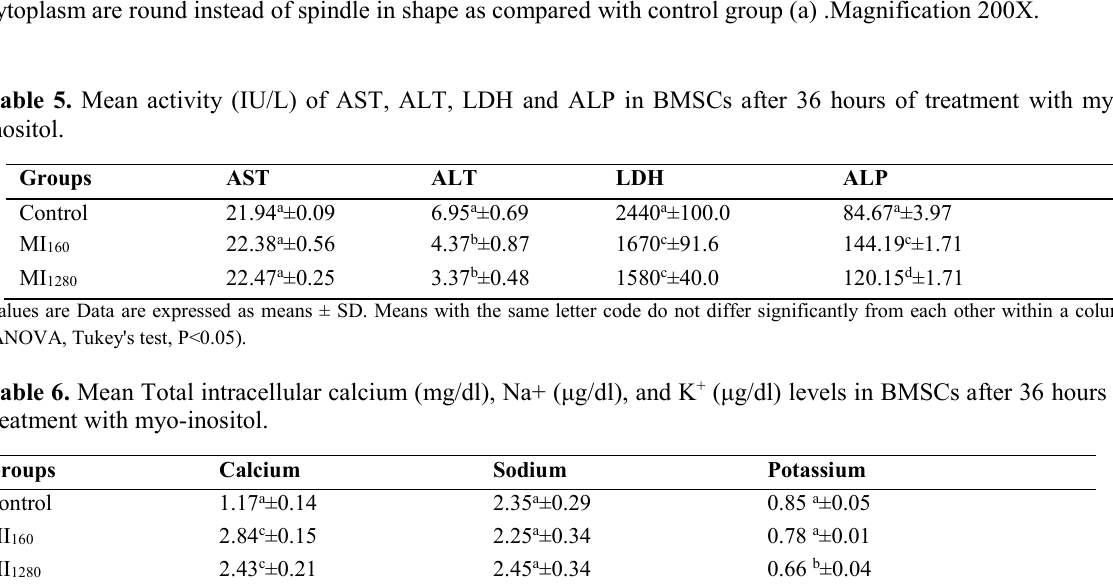
Fig. 2. Fluorescent micrograph of BMSCs stained with acridine orange, after 36 hours of treatment with MI. Differences in the shape of the cell cytoplasm can be observed in the groups treated with MI (b and c), where the cytoplasm are round instead of spindle in shape as compared with control group (a) .Magnification 200X.